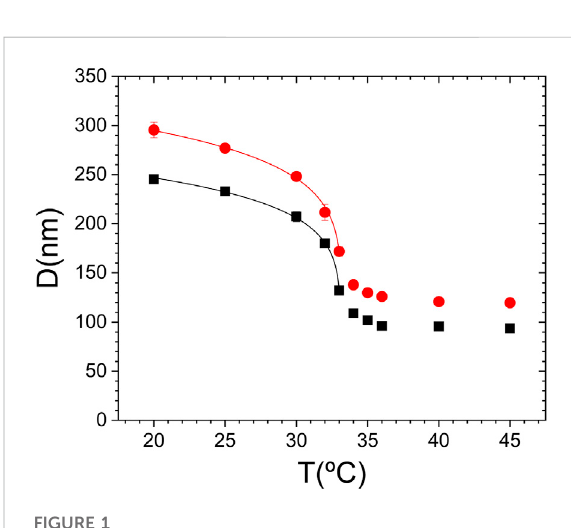
FIGURE 1 Temperature dependence of the hydrodynamic radius for KPS0.1 (black squares) and KPS0.6 (red circles) samples. The continuous lines are fi ts the critical-like function D H = A ( T c - T ) B